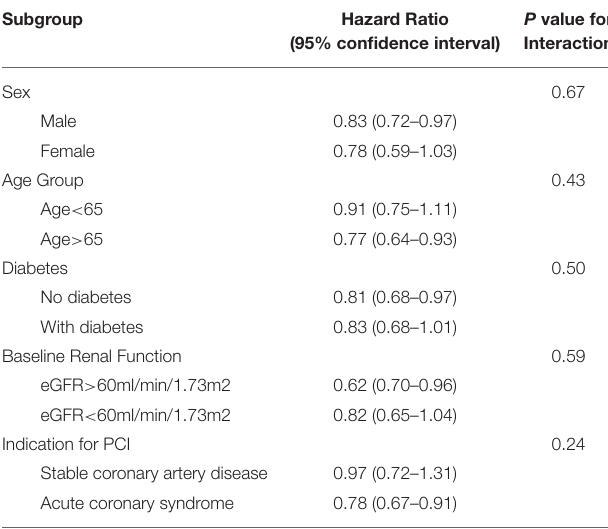
TABLE 5 | Major adverse cardiovascular events in group 2 (intensity criteria only) compared with group 1(target criteria) in predefined subgroups.